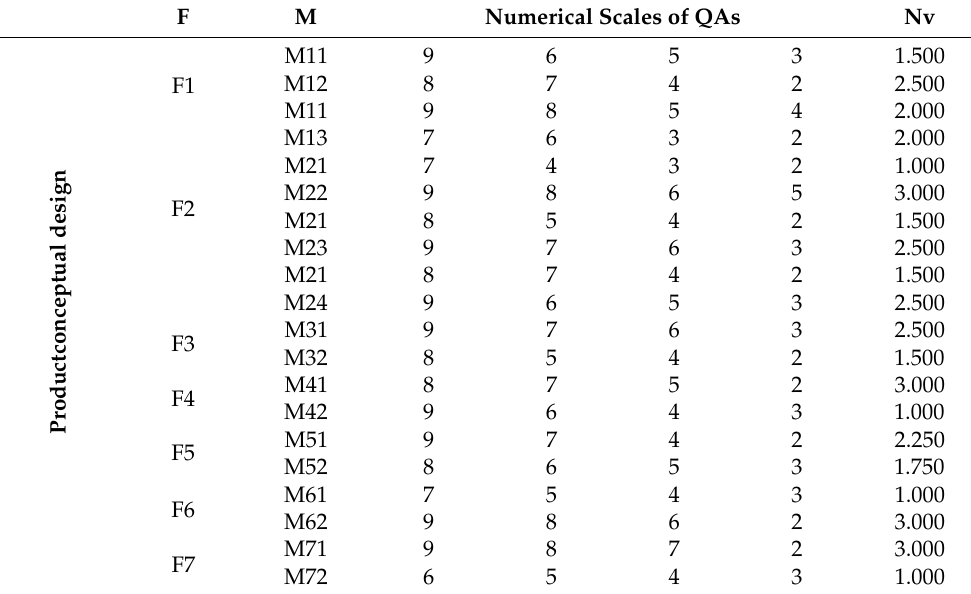
Table 3. Sub-functions means (M) with QAs numerical scales and M numerical